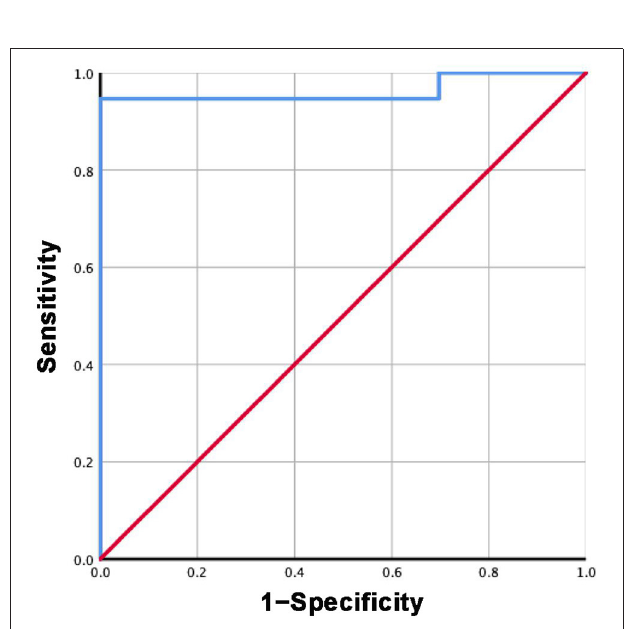
FIGURE 8 | ROC curve of sST2 levels between HF and healthy groups measured by Presage ® ST2 assay kit.